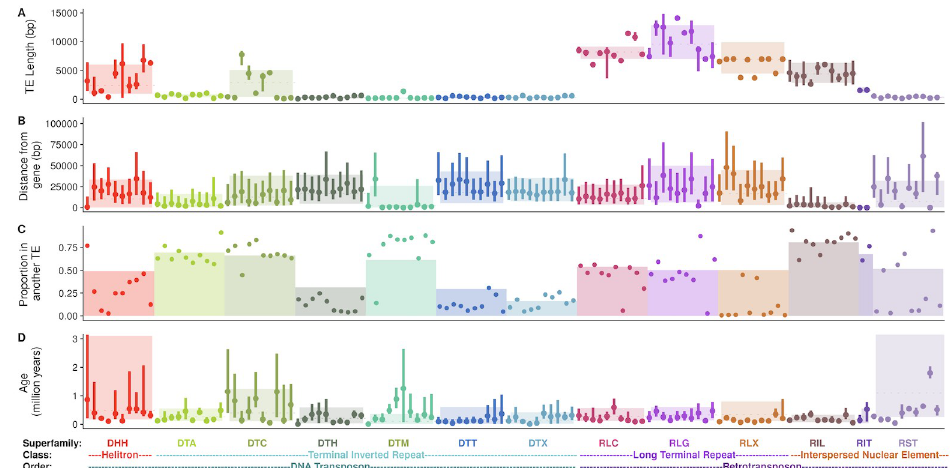
Fig 2. Characteristics of each superfamily of TE. Superfamilies are classified into orders and classes, as shown at the bottom of the plot. (A-D) Family characteristics of each of the most numerous 10 families (with � 10 copies) of each superfamily. Family names are listed in S1 Table. (A) TE length, (B) Distance to the closest gene, (C) proportion of TE copies found within another TE, and (D) TE age. In (A, B, & D) family medians are shown as points, with lines representing upper to lower quartiles. Superfamilies are shown as colored rectangles, where the dotted line reflects the median and box boundaries reflect lower and upper quartiles. In (C), families are shown as points and superfamily proportions as a